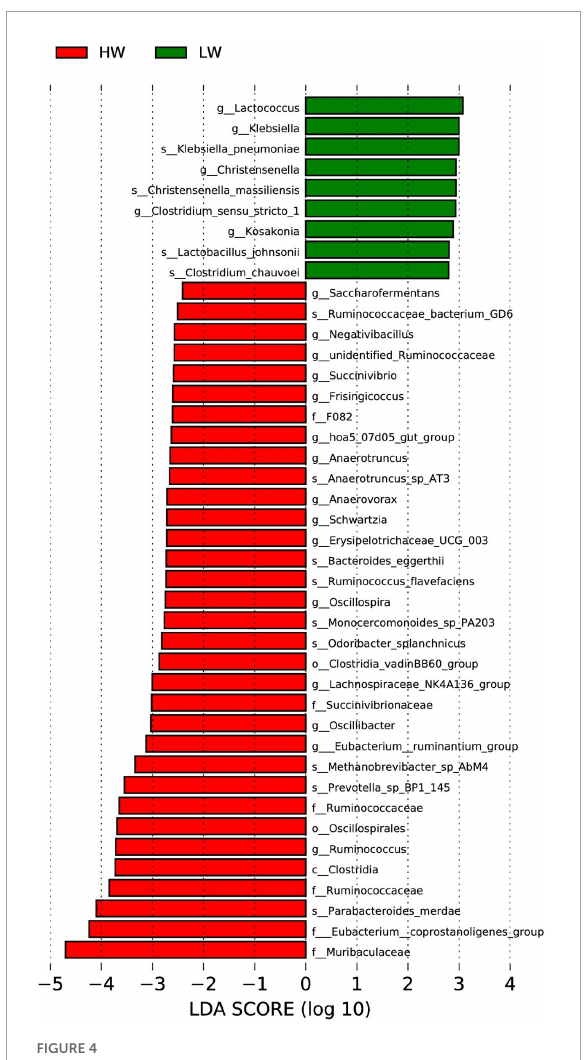
FIGURE4 Significant differentiation of bacterial taxa between HW and LW groups was determined by linear discriminant analysis and effect size (LEfSe). LDA scores were calculated for bacterial taxa that were differentially enriched between different groups.